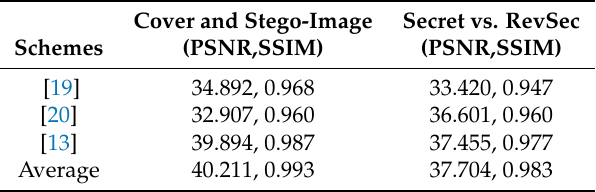
Table 4. Comparison with other